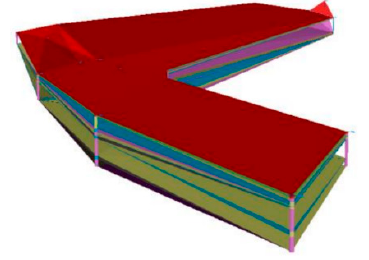
Figure 7. 3D subsurface model for Case Study 2 based on the detailed soil investigation data.